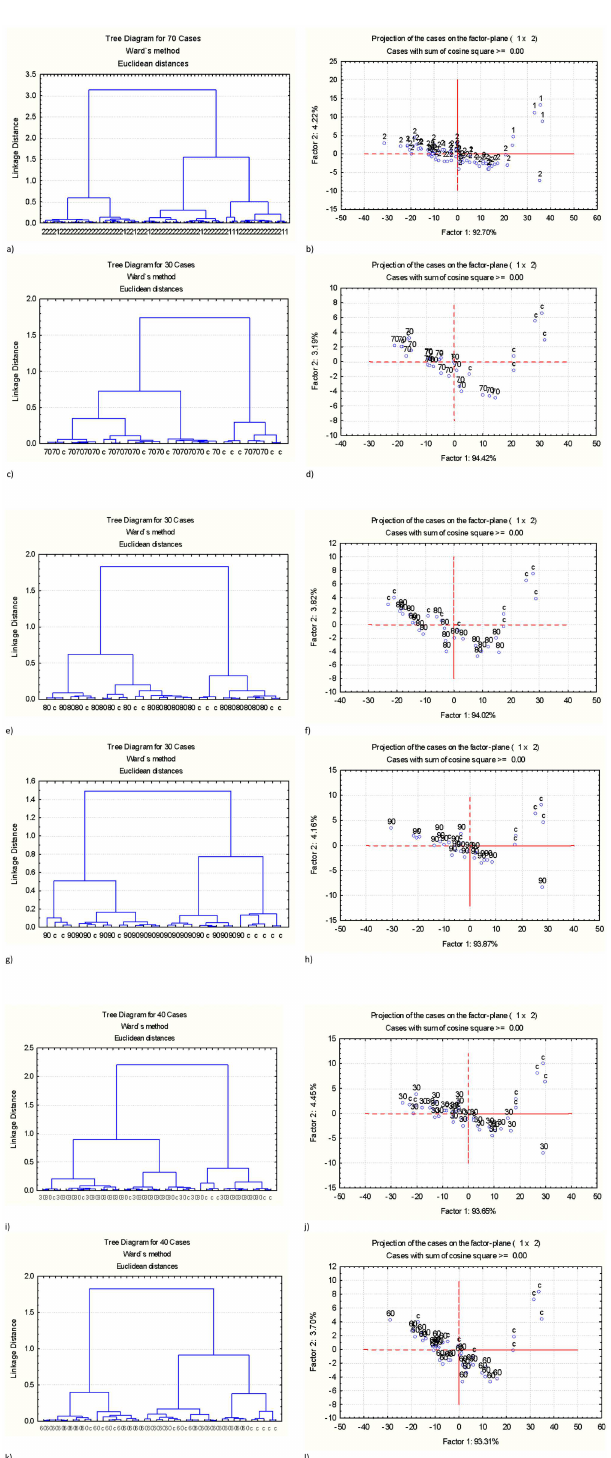
Fig 4. Multivariate molecular spectral analysesof protein fingerprint region at ca. 1718–1481 cm -1 . Comparison of the unprocessed mash to samples conditioned under different conditions using cluster analysis(Cluster method: Ward’s algorithm; (2) Distance method: Euclidean) and principal component analysis[Scatter plots of the 1st principalcomponents (PC1) vs. the 2nd principal components (PC2)]: (a) CLA: unprocessed mash (1) vs. pellets(2); (b) PCA: unprocessed mash (1) vs. pellets (2); (c) CLA: